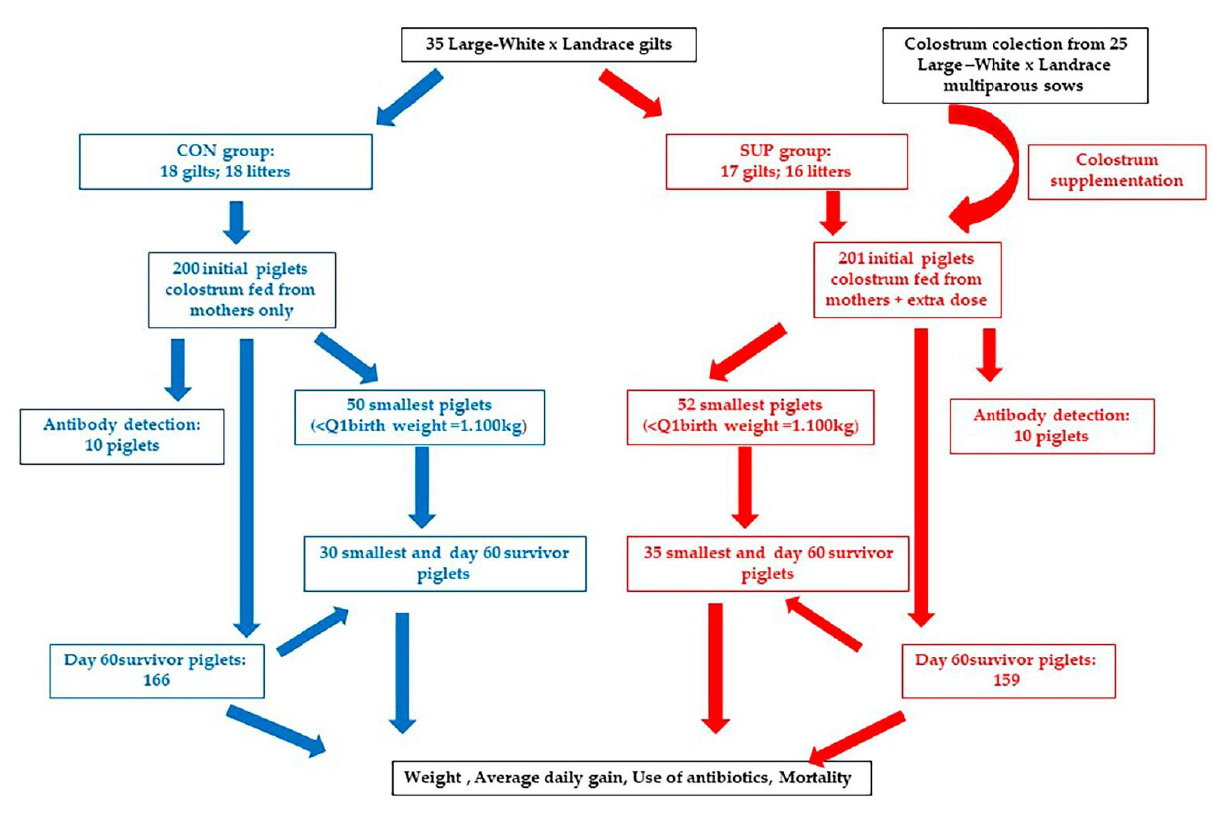
Figure 1. Study design. CON: control group; SUP: colostrum supplemented group. See Material and Methods for details. Weight and average daily gain were only analysed in day 60 survivor piglets.